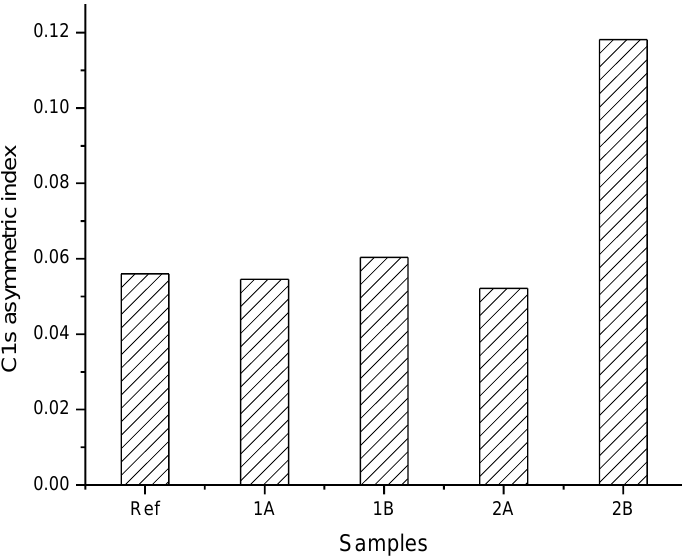
Figure 7. Cross-linking of C 32 H 66 thin films induced by hyperthermal hydrogen bombardment effects on C1s peak asymmetric index, prepared at a concentration of 0.3% w/v. Ref : as-prepared thin film. 1A and 1B: fully cross-linked C 32 H 66 after the bombardment and hexane washing, respectively. 2A and 2B: partially cross-linked C 32 H 66 films (about 25% cross-linking) and hexane-washing, respectively.